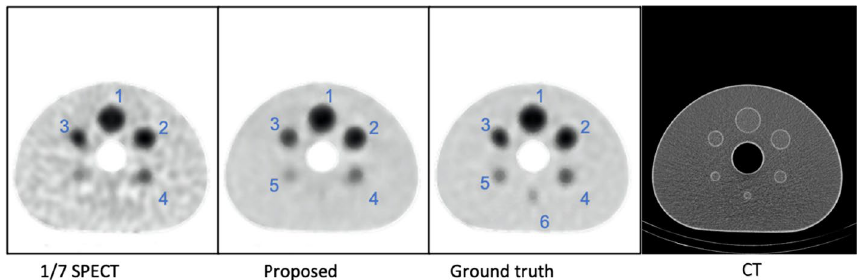
Fig. 7 Visualization results of phantom images from different methods. On 1/7 SPECT, only 4 spheres can be identified that exhibited evident contrast against background signals. On the generated image and the ground truth image, 5 and 6 spheres can be distinguished separately